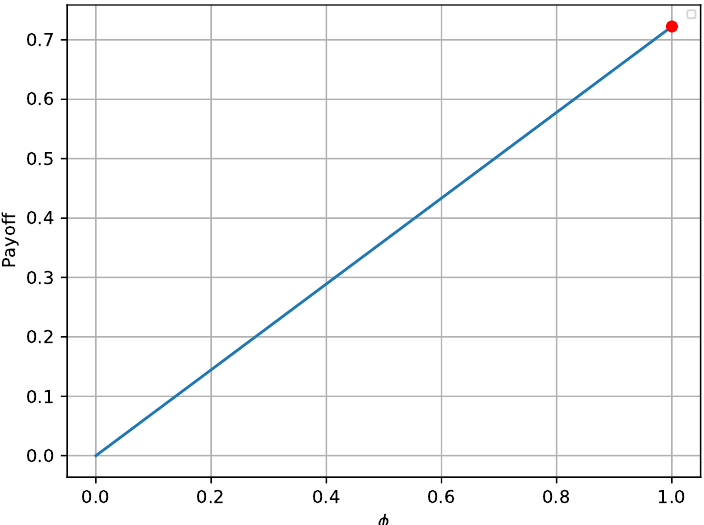
Figure 2. Attacker’s payoff for different strategies in the one-shot game.